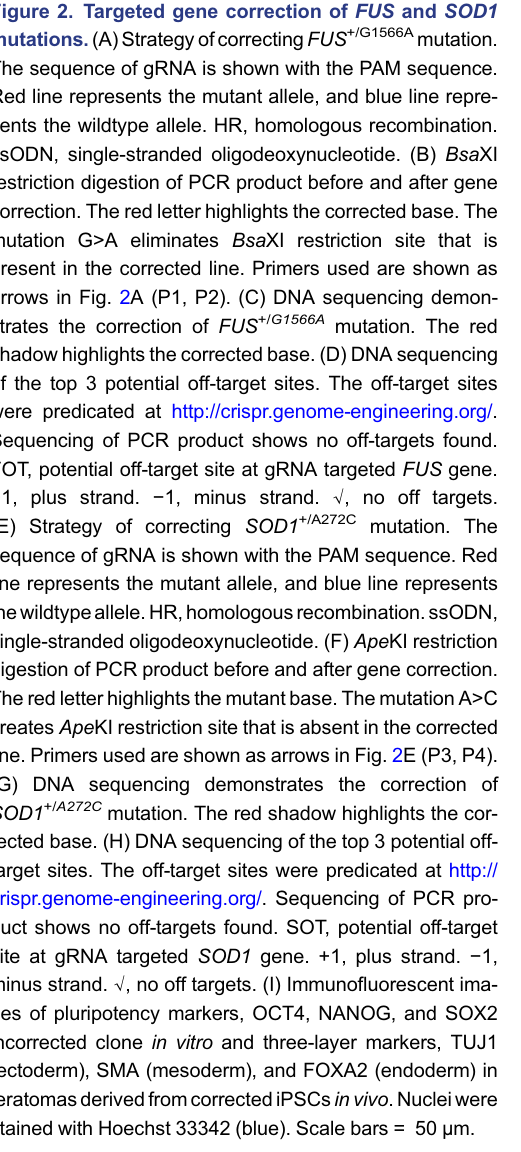
Figure 2. Targeted gene correction of FUS and SOD1 mutations. (A)Strategyofcorrecting FUS +/G1566A mutation. The sequence of gRNA is shown with the PAM sequence. Red line represents the mutant allele, and blue line repre- sents the wildtype allele. HR, homologous recombination. ssODN, single-stranded oligodeoxynucleotide. (B) Bsa XI restriction digestion of PCR product before and after gene correction. The red letter highlights the corrected base. The mutation G>A eliminates Bsa XI restriction site that is present in the corrected line. Primers used are shown as arrows in Fig. 2A (P1, P2). (C) DNA sequencing demon- strates the correction of FUS +/ G1566A mutation. The red shadow highlights the corrected base. (D) DNA sequencing of the top 3 potential off-target sites. The off-target sites were predicated at http://crispr.genome-engineering.org/. Sequencing of PCR product shows no off-targets found. FOT, potential off-target site at gRNA targeted FUS gene. +1, plus strand. − 1, minus strand. √ , no off targets. (E) Strategy of correcting SOD1 +/A272C mutation. The sequence of gRNA is shown with the PAM sequence. Red line represents the mutant allele, and blue line represents thewildtypeallele.HR,homologousrecombination.ssODN, single-stranded oligodeoxynucleotide. (F) Ape KI restriction digestion of PCR product before and after gene correction. The red letter highlights the mutant base. The mutation A>C creates Ape KI restriction site that is absent in the corrected line. Primers used are shown as arrows in Fig. 2E (P3, P4). (G) DNA sequencing demonstrates the correction of SOD1 +/ A272C mutation. The red shadow highlights the cor- rected base. (H) DNA sequencing of the top 3 potential off- target sites. The off-target sites were predicated at http:// crispr.genome-engineering.org/. Sequencing of PCR pro- duct shows no off-targets found. SOT, potential off-target site at gRNA targeted SOD1 gene. +1, plus strand. − 1, minus strand. √ , no off targets. (I) Immuno fl uorescent ima- ges of pluripotency markers, OCT4, NANOG, and SOX2 incorrected clone in vitro and three-layer markers, TUJ1 (ectoderm), SMA (mesoderm), and FOXA2 (endoderm) in teratomasderivedfromcorrectediPSCs invivo .Nucleiwere stained with Hoechst 33342 (blue). Scale bars = 50 μ